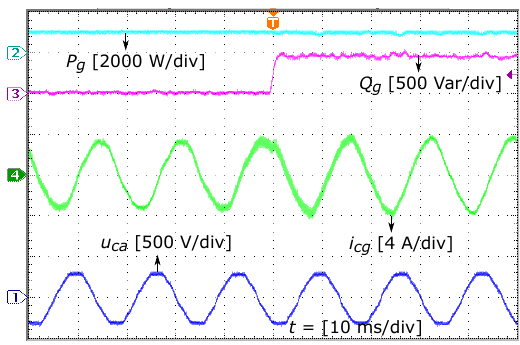
Figure 15. Experimental results of the step change in active power from 0 to 1300 W with Q g = 0 Var.